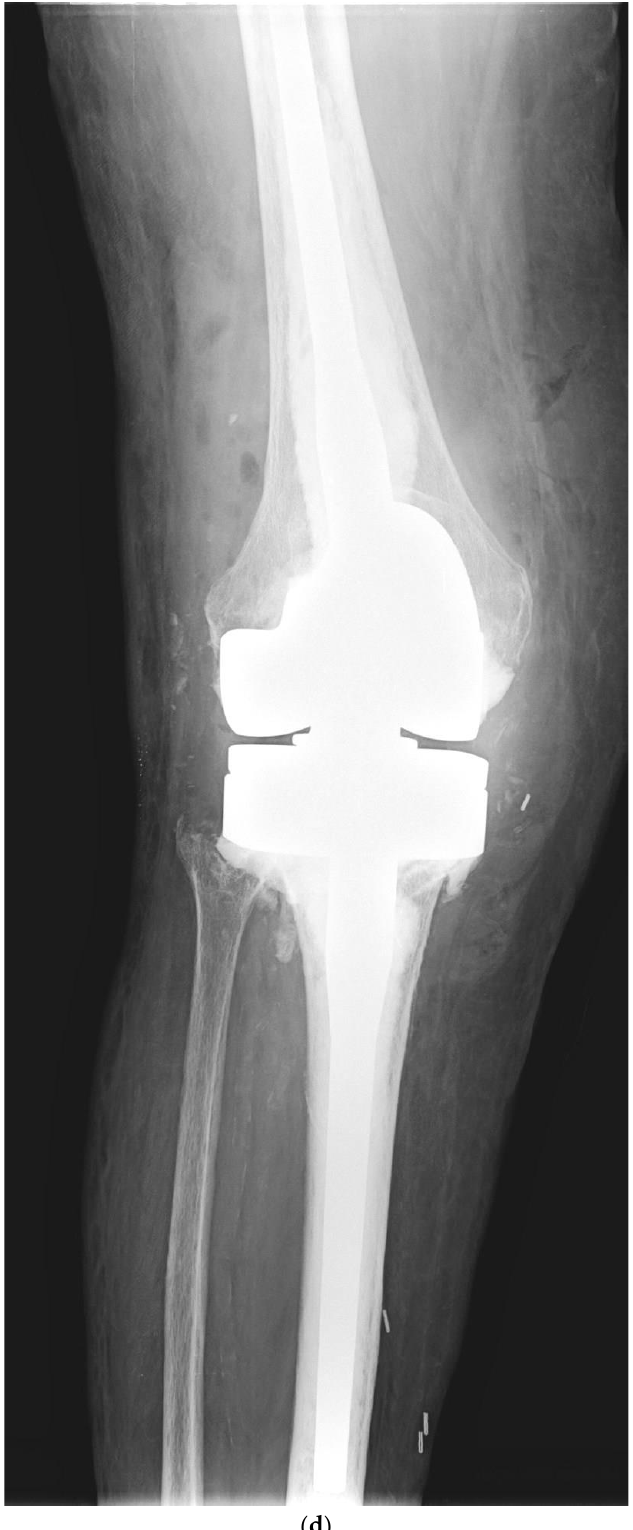
Figure 1. (a – d). Periprosthetic joint infection of a primary total knee arthroplasty (TKA) that was resolved by a two-stage revision TKA: ( a ) preoperative anteroposterior (AP) radiograph; ( b ) pre- operative lateral image; ( c ) postoperative AP radiograph showing the prosthesis implanted in the second-stage revision (rotational hinge design); ( d ) lateral image of the aforementioned prosthesis.